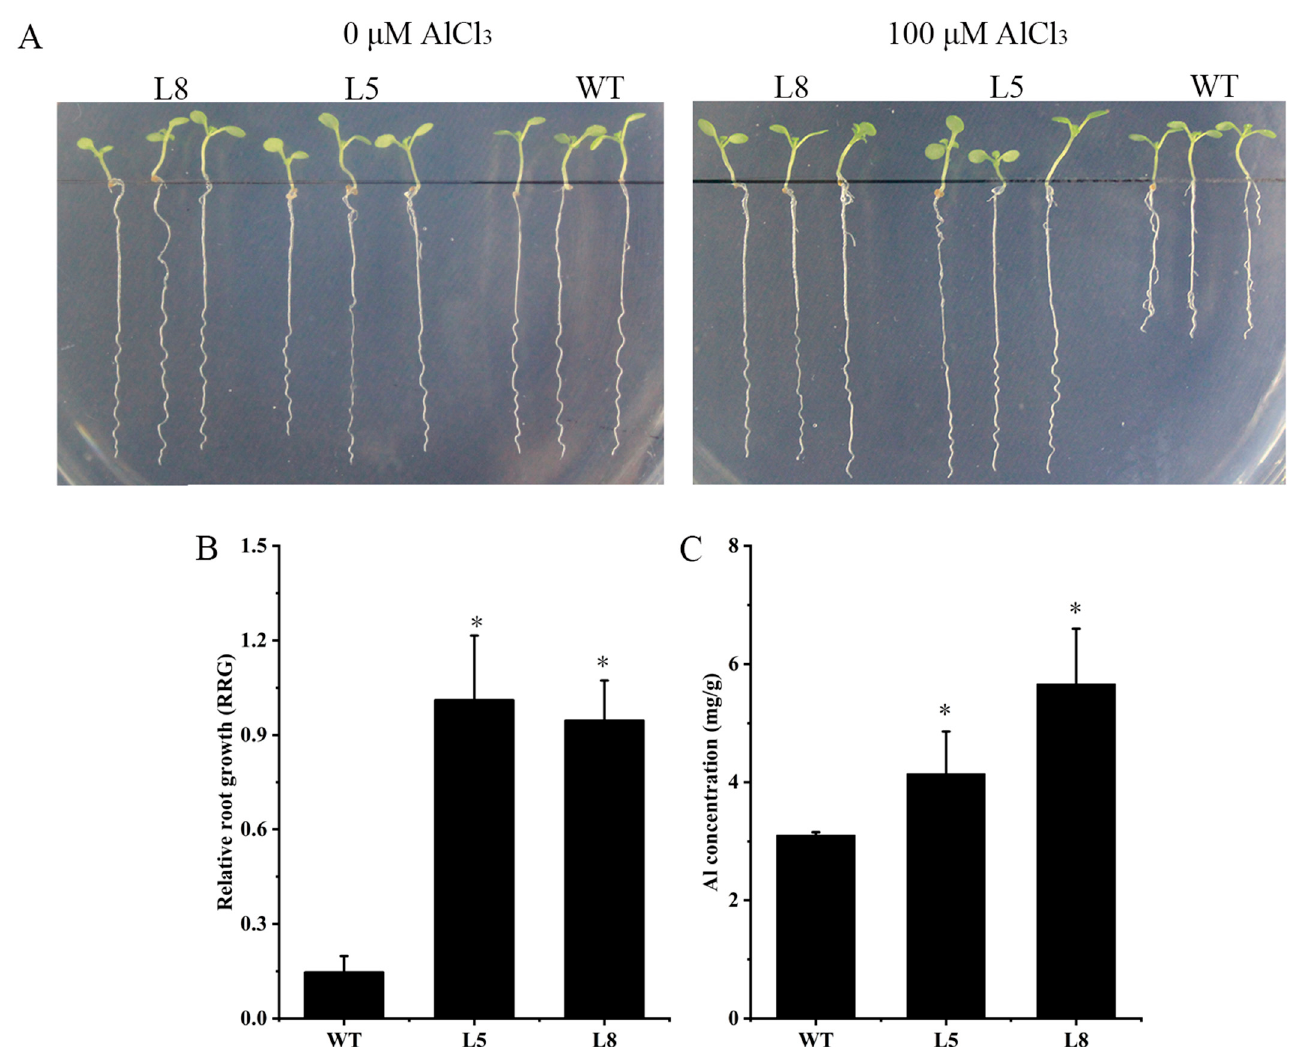
Figure 5. Phenotype of ZmNRAMP4-overexpressed transgenic Arabidopsis plants under Al stress. ( A ) Al sensitivity, ( B ) relative root growth (RRG), and ( C ) Al concentration in wild-type and ZmNRAMP4 transgenic plants. The 14-day-old seedlings were exposed to one-fifth Hoagland solution (pH 4.7) containing 100 µM Al for 12 h. Asterisk indicated a significant difference from control at p < 0.05 by Tukey’s test with three independently biological replicates.